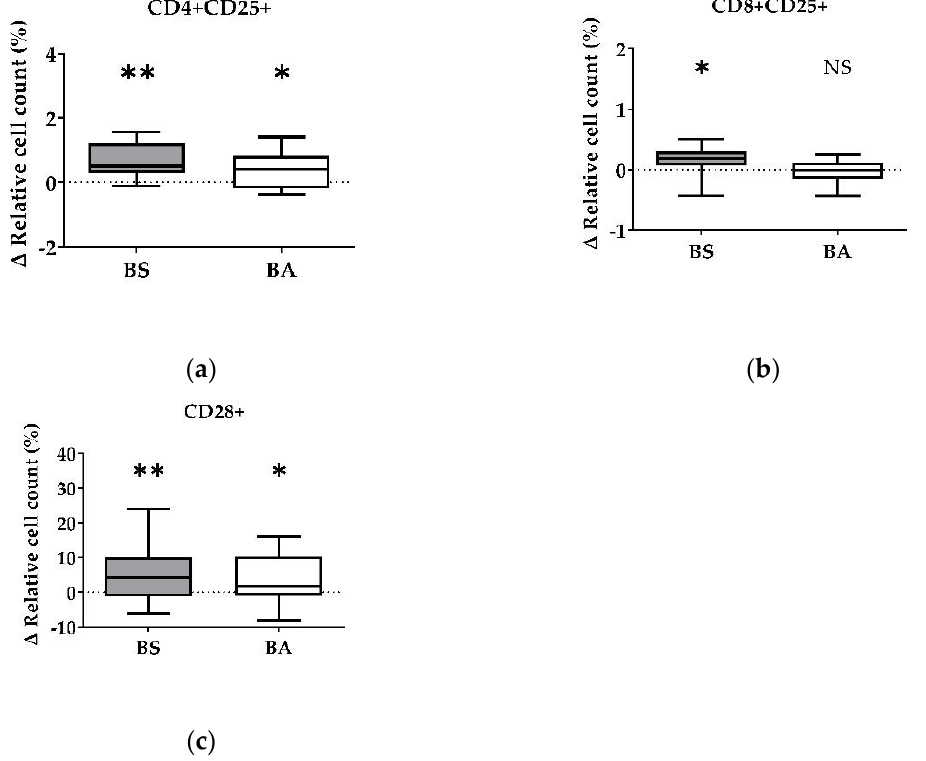
Figure 2. Influence of vital B. subtilis DSM 32315 (grey) and B. amyloliquefaciens CECT 5940 (white) on activation of T cells. Isolated PBMCs were treated with BS or BA in a ratio of 1:3 (PBMCs: Bacillus ), or left untreated (negative control). After treatment for 24 h, immune cells were stained with monoclonal antibodies. The relative cell count was related to untreated controls. DAPI was used as a